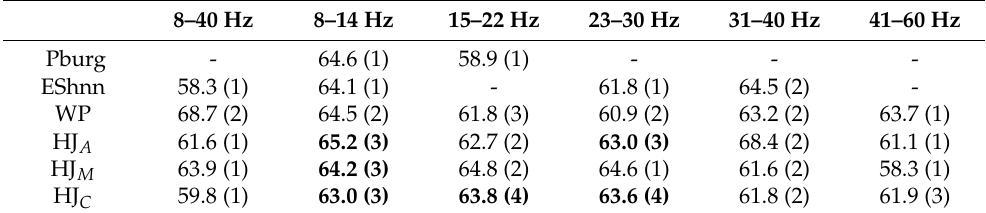
Table 2. Average of the accuracy of the features that among all the models exceeded the established thresholds. In parentheses is shown the number of users it appeared. Selected features are in bold. If they did not pass the inclusion criteria, it was indicated with